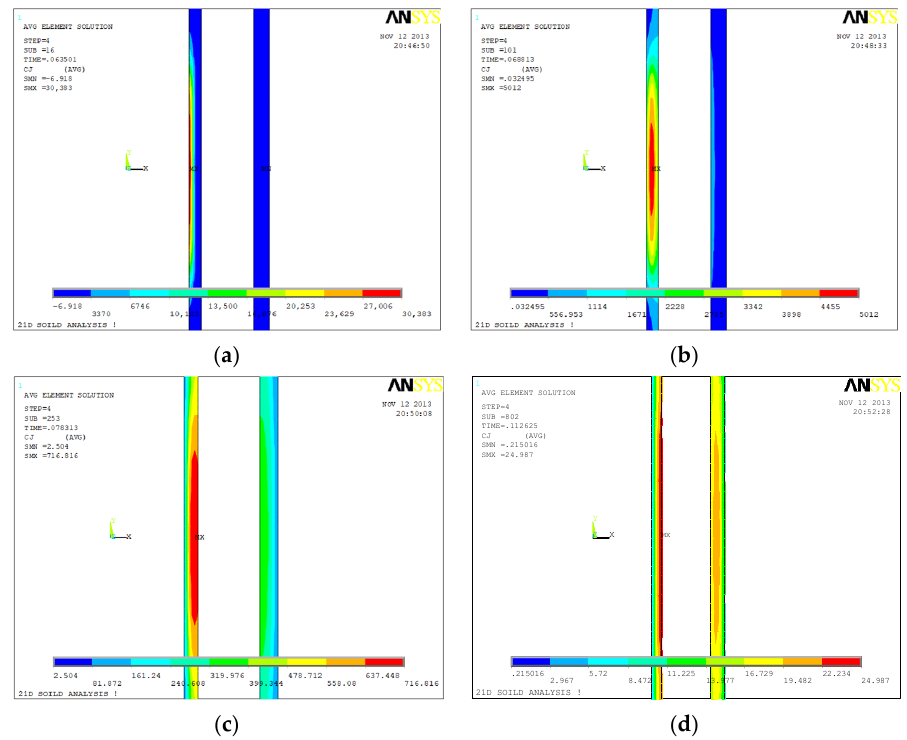
Figure 6. Eddy current distribution during power-off time in the inspection for undamaged casing plus undamaged tubing: ( a ) 0.0635 s (time slice No. 16); ( b ) 0.0688 s (time slice No. 22); ( c ) 0.0783 s (time slice No. 26); ( d ) 0.112 s (time slice No. 31).